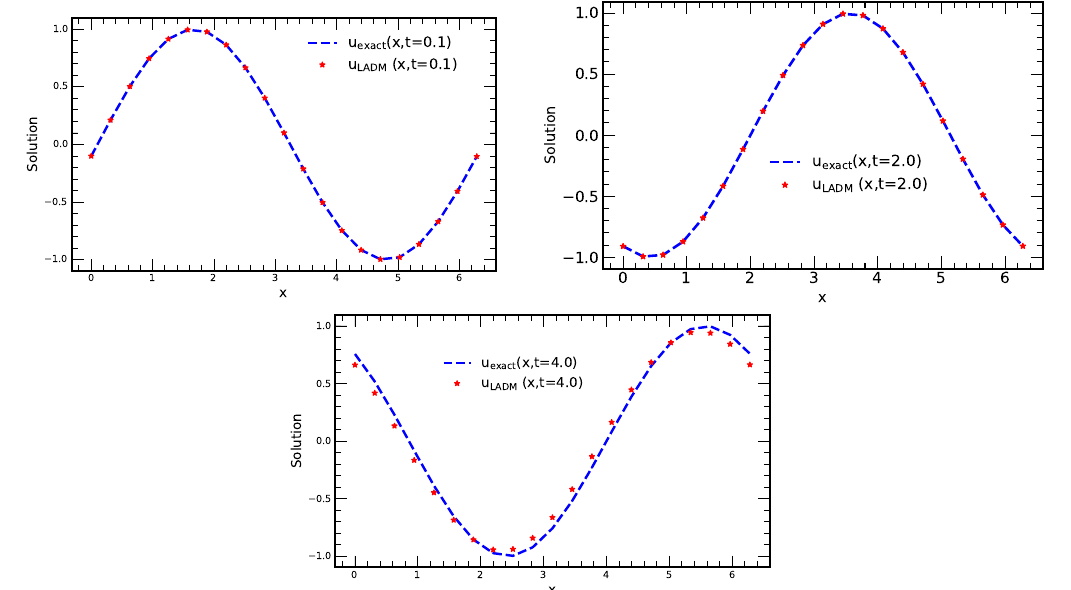
Figure 1. Plots of exact solution and approximate solution using 10-terms of LADM, HPM, RDTM vs. x at times 0.1, 2.0 and 4.0. (The space interval used for these plots is π